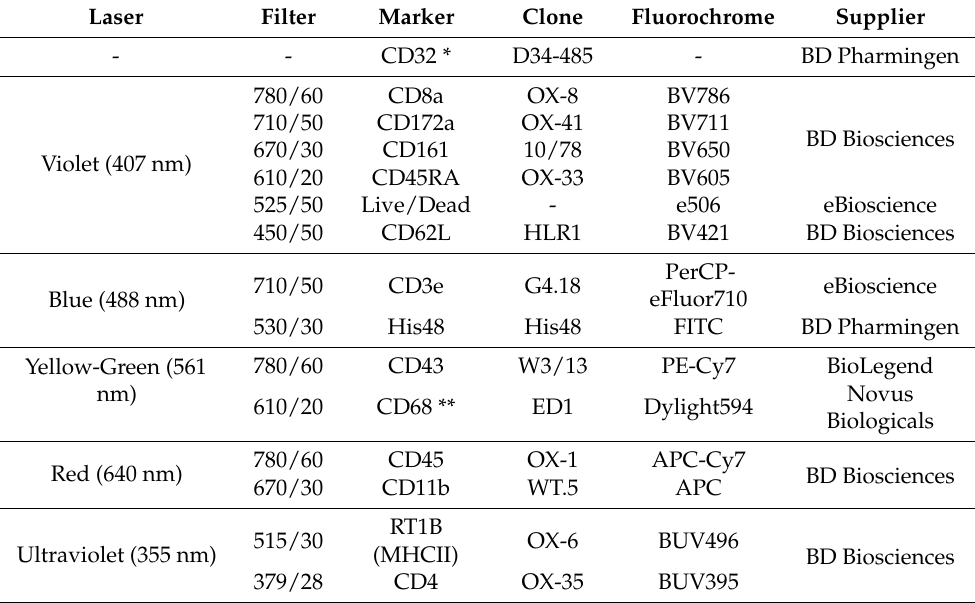
Table 1. Monoclonal antibodies and dyes used for flow cytometric leukocyte phenotyping. Laser